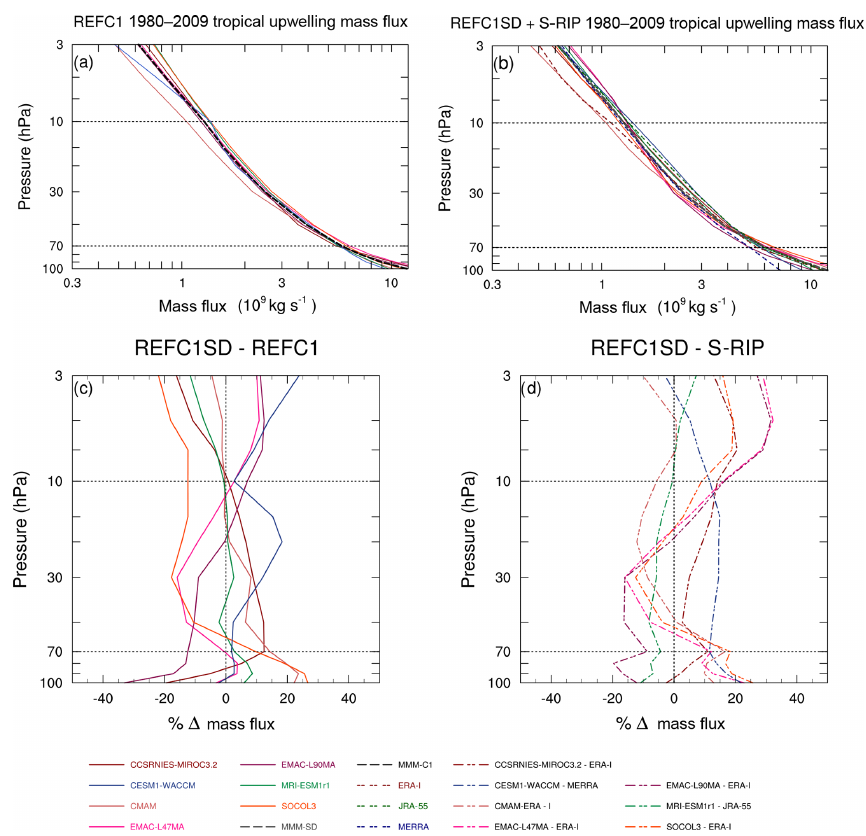
Figure 4. Vertical profiles of climatological (1980–2009) tropical upward mass flux (10 9 kgs − 1 ) averaged between the turnaround latitudes for (a) REF-C1 and (b) REF-C1SD, (c) differences (%) between REF-C1SD and REF-C1, and (d) % differences between REF-C1SD and the respective reanalysis used for nudging. Note the logarithmic x axis in panels (a) and (b)